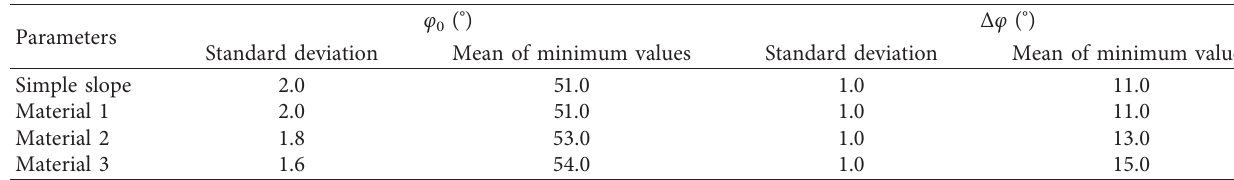
Table 5: List of parameters used for the model calculation.